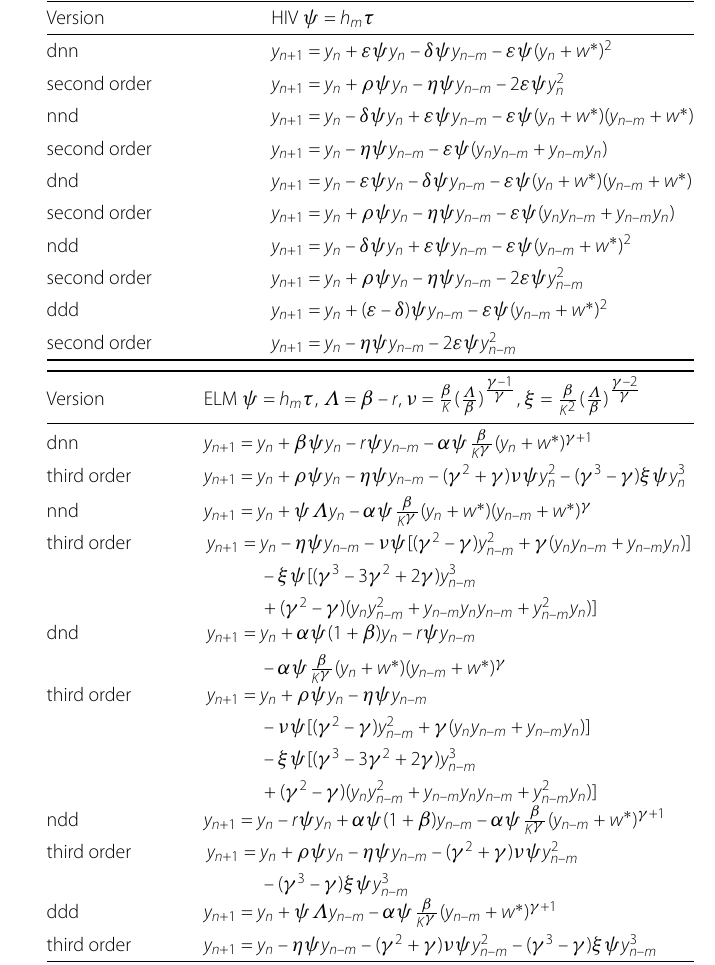
Table 5 Nonlinear discrete HIV and ELM equations for versions with Neimark–Sacker bifurcations (values of ρ and η are given in Table